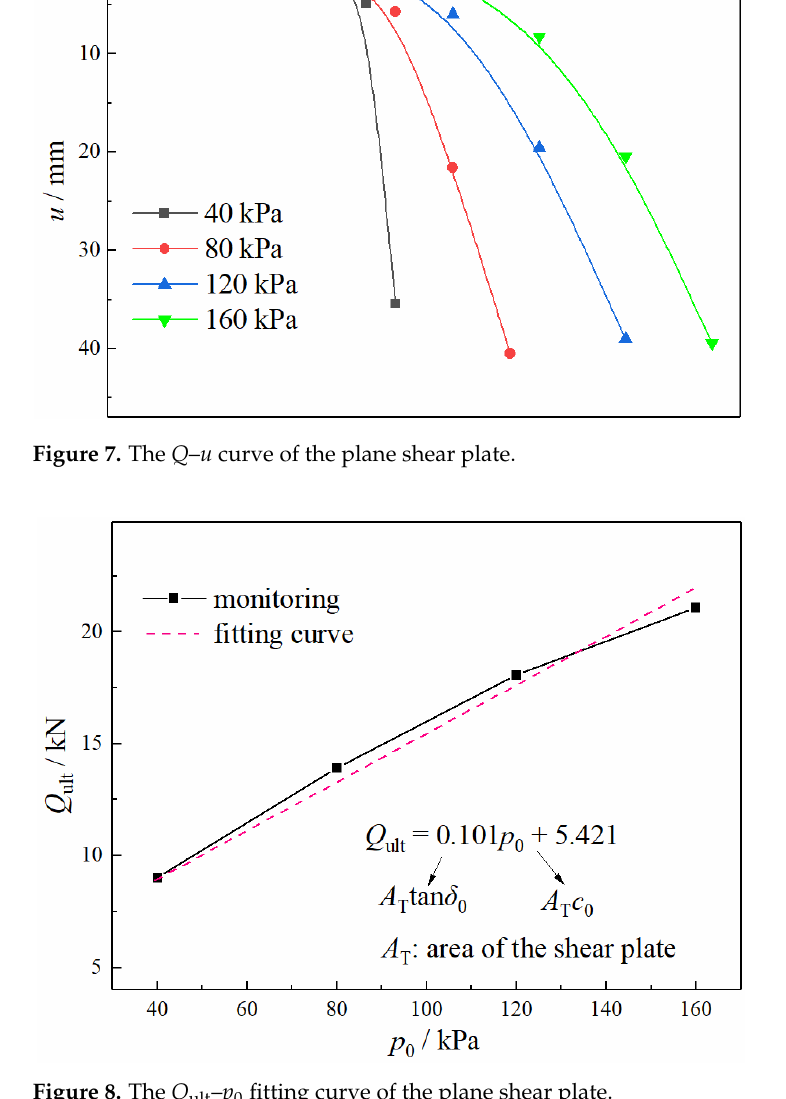
Figure 8. The Q ult – p 0 fitting curve of the plane shear plate.